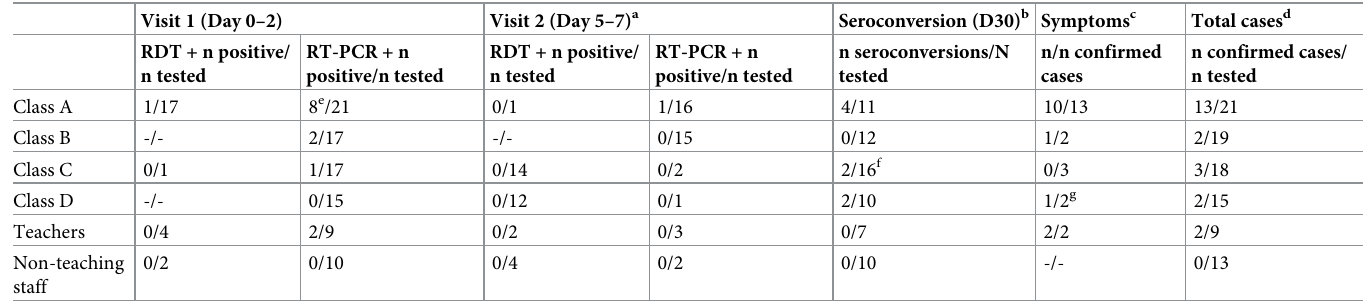
Table 1. Overview of tests results, symptoms and cases among the 4 investigated classes, teachers and non-teaching staff. Visit 1 (Day